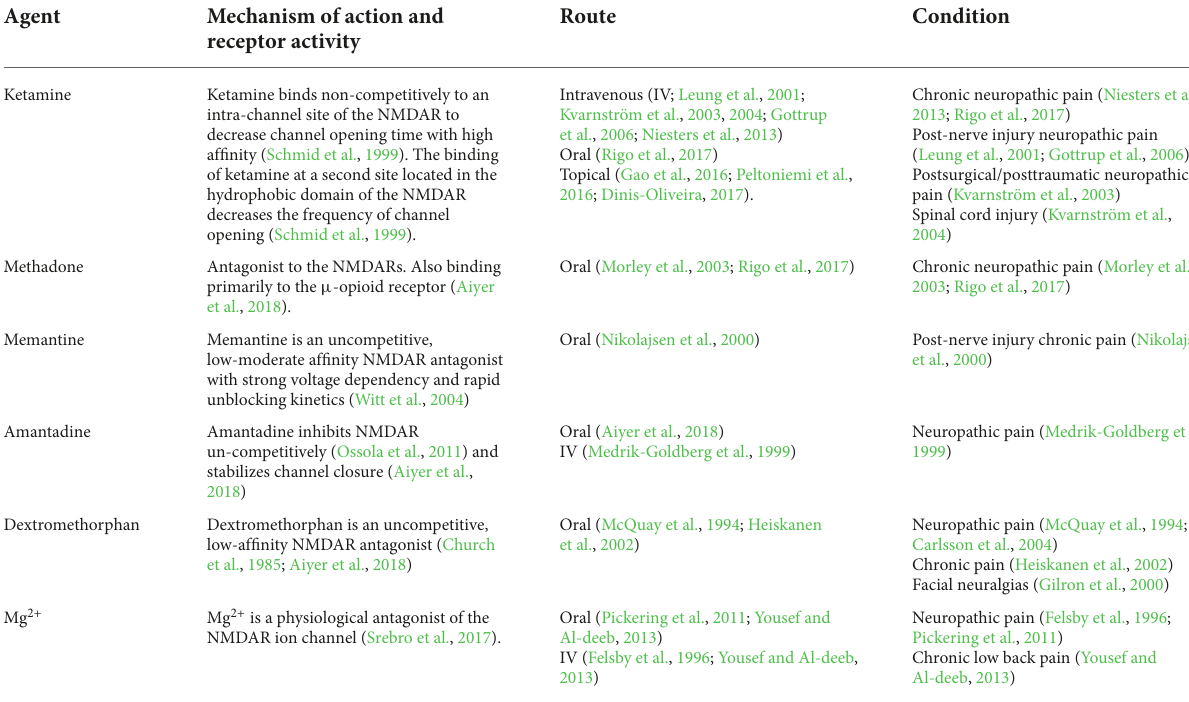
TABLE 1 Summary of NMDAR antagonists for the treatment of pain in clinical trials. Agent Mechanism of action and Route receptor activity